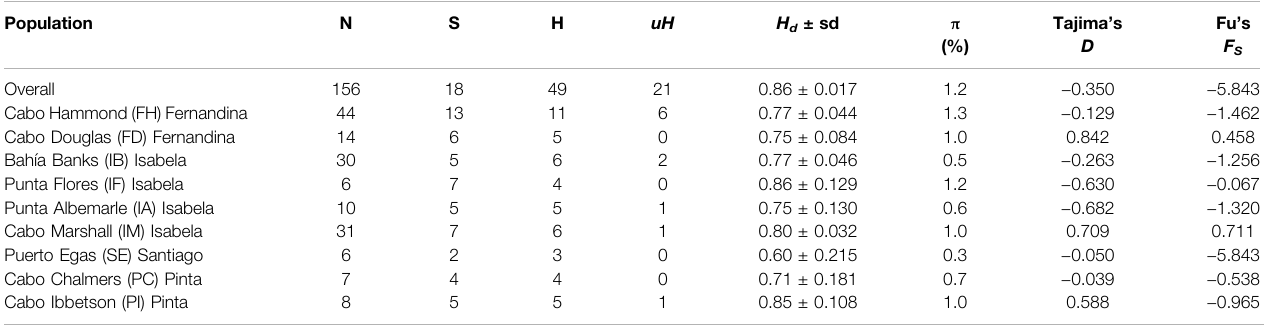
TABLE 1 | Genetic diversity ( Hd = haplotype diversity, π = nucleotide diversity and demographic parameters (Tajima ’ s D and Fu ’ s F S ) estimated from the mtDNA control region sequences of Galapagos fur seal ( Arctocephalus galapagoensis ). N = number of samples; S = variable sites; H = total number of haplotypes; uH = number of unique haplotypes (not shared among sites); Hd = Haplotype diversity ( ± sd =standarddeviation);and π = nucleotide diversity ( % ).Neither Tajima ’ sDnorFu ’ s F S resultedin signi fi cance ( p < 0.05) for any population (actual p-values values not displayed). Population